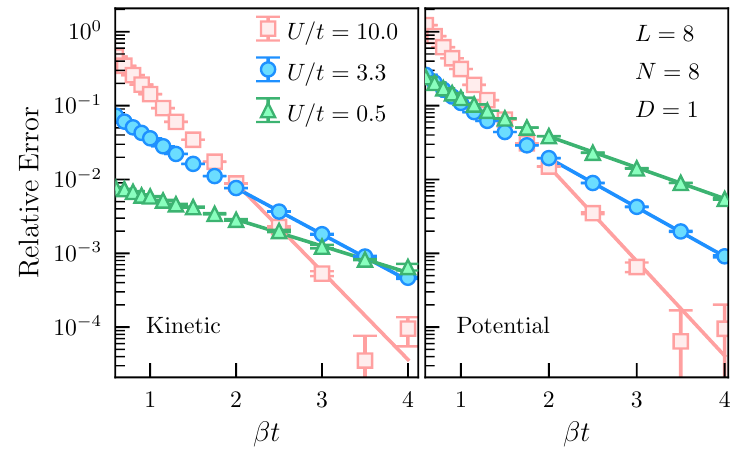
Figure 4: Relative error of the ground state kinetic energy ( left ) and potential energy ( right ) as a function of β t for a Bose-Hubbard chain of L = 8 sites at unit-filling. As β increases, the relative error decays exponentially to zero, as evidenced by the fits (solid lines). Regimes where the interaction strength is large possess a sizeable energy gap and more accurate results can be obtained at lower β t values, since the ground state is projected out of the trial wavefunction much faster. The different shapes and colors correspond to different interaction strengths. The interactions strengths U / t = 0.5,3.3,10.0 represent values in the superfluid phase, the 1D critical point, and the Mott phase, respectively. The measurement window is ∆ τ = 0.2 β t